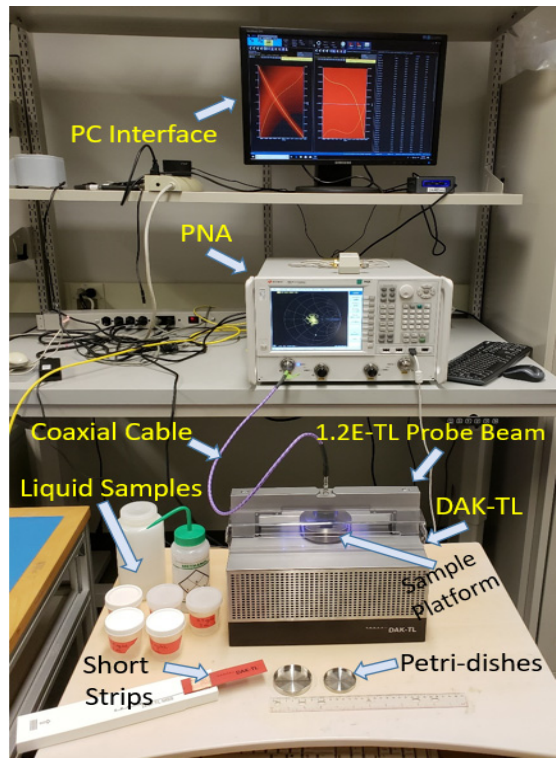
Figure 1. DAK-TL system setup for dielectric measurements of glucose solutions.